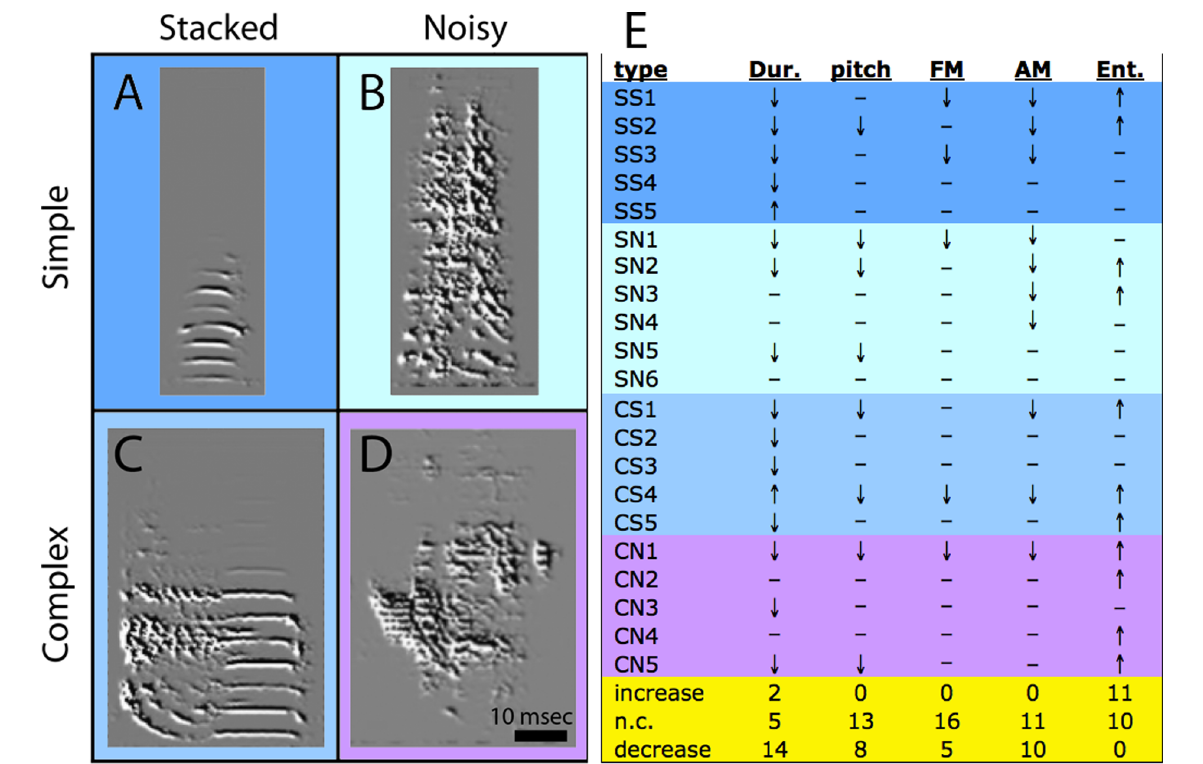
Fig. 8. Left: Syllable types in zebra finch song. Shown are representative examples of (A) simple stacked (SS), (B) simple noisy (SN), (C) complex stacked (CS) and (D) complex noisy (CN) syllables. Simple stacked syllables are represented by single harmonics stacks or clear tones, whereas simple noisy syllables are single elements that lack well defined harmonic structure. Complex stacked types contain a combination of harmonic stacks and noisy elements, whereas complex noisy have multiple noisy elements but no harmonic stacks. Right: Effects of alcohol on zebra finch song syllable types. Direction of arrows indicate direction of change (up or down), dashes indicate lack of change. Frequencies of directional shifts are tallied at the bottom (yellow).